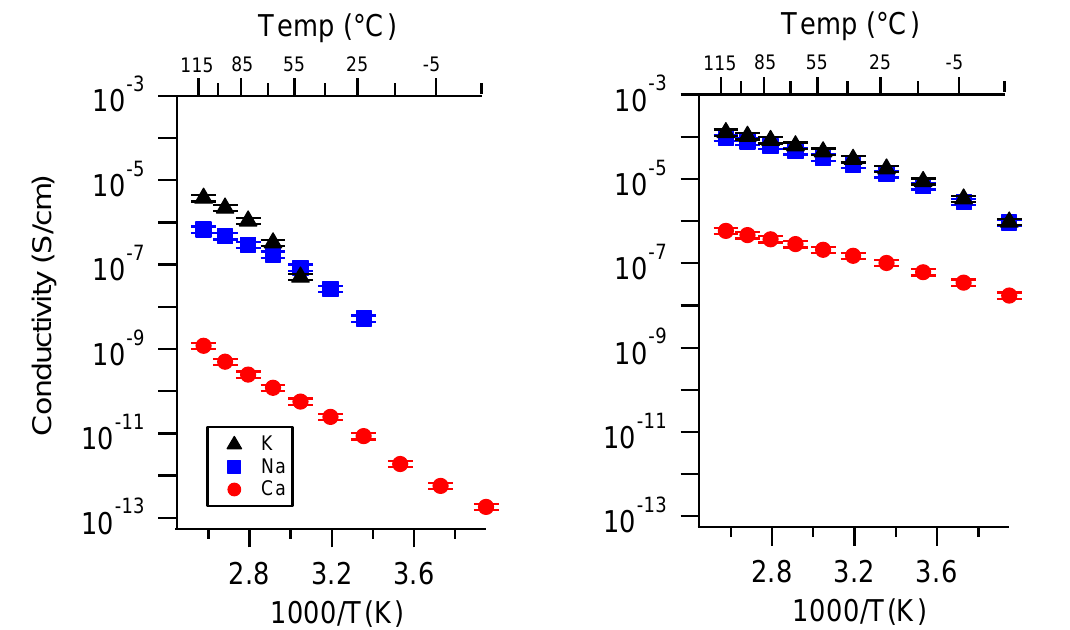
Figure A6. Conductivity as a function of cation for PEGDMA1000_high_SSM (left) and PTHFDA1000_high_STFSI (right) SIPEs swelled with TEG. Temperatures ranged from − 20 °C to 115 °C.